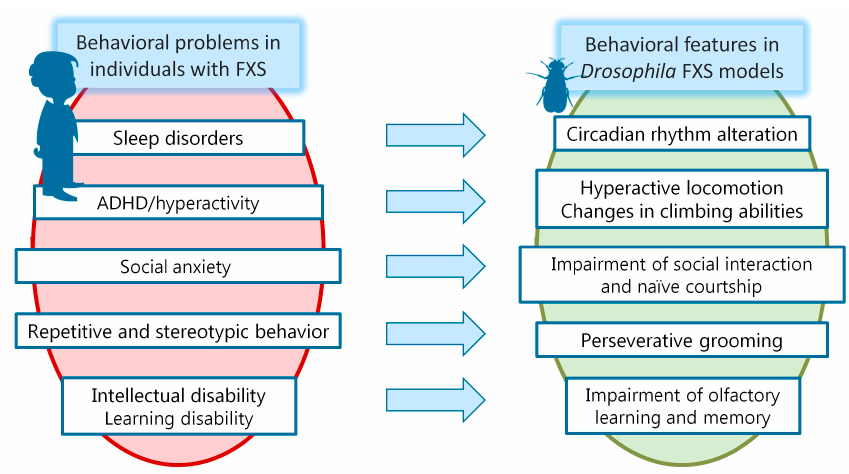
Figure 3. Major phenotypes in humans with FXS and overlapping loss-of-function phenotypes in dfmr1 mutants.